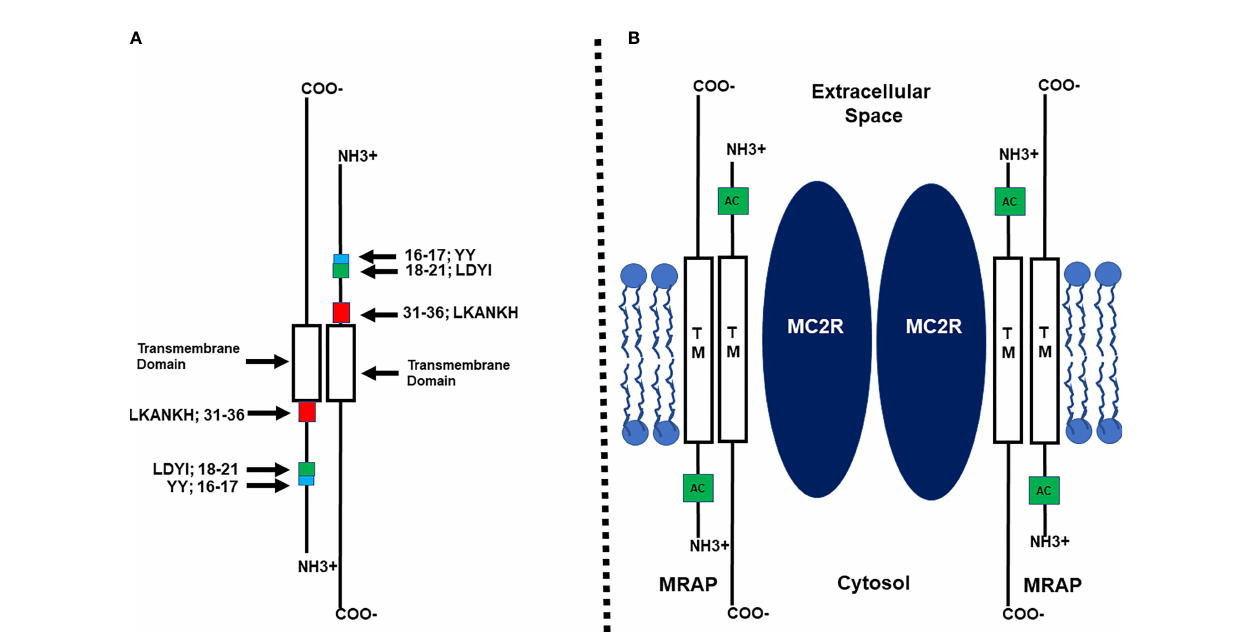
FIGURE 1 | (A) Schematic representation of the functional regions of mouse MRAP1 (not drawn to scale) based on the study by Sebag and Hinckle (14). Within the N-terminal domain there are three functional motifs: Y 16 Y 17 , the extended activation motif; L 18 D 19 Y 20 I 21 , the activation motif; L 31 K 32 A 33 N 34 K 35 H 36 , the reverse topology motif. The Transmembrane domain (TM) is required for facilitating the traf fi cking of MC2R to the plasma membrane. (B) Diagram of the MC2R/MRAP1 heterodimer (not drawn to scale) based on the study by Cooray et al. (15). Two MRAP homodimers form a heterodimer with a MC2R homodimer. TM, Transmembrane Domain; AC, Activation